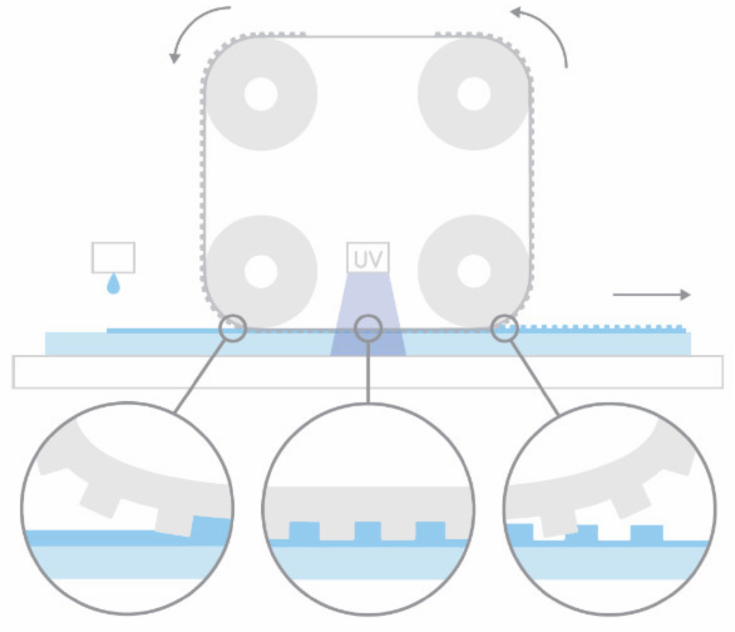
Figure 6. Schematic diagram of Morphotonics’ roll-to-plate ultraviolet nanoimprint lithography (R2P NIL) process (Morphotonics, Veldhoven, The Netherlands)